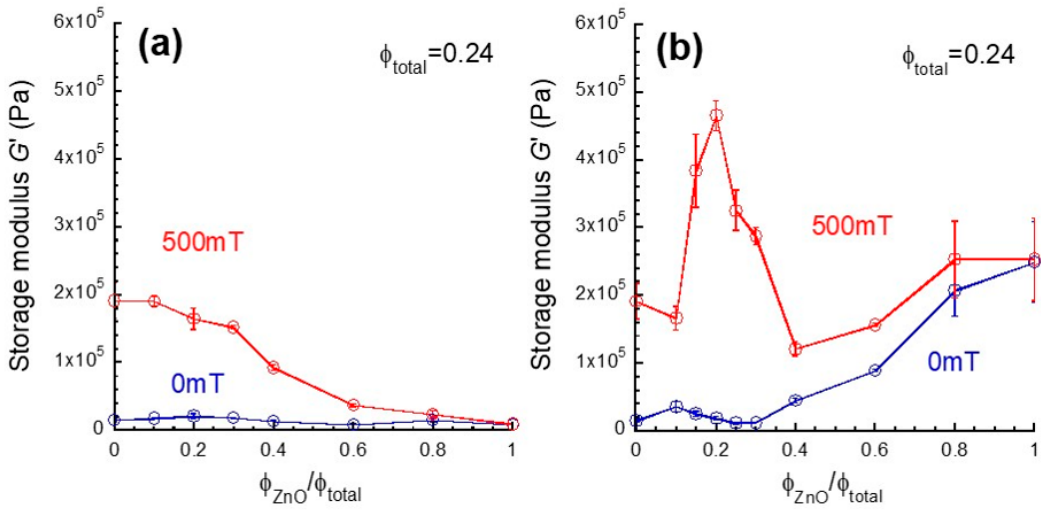
Figure 4. Storage modulus at 0 and 500 mT for bimodal magnetic elastomers containing nonmagnetic ( a ) particles or ( b ) tetrapods as a function of the substitution ratio (Frequency 1 Hz, Strain 10 − 4 ).